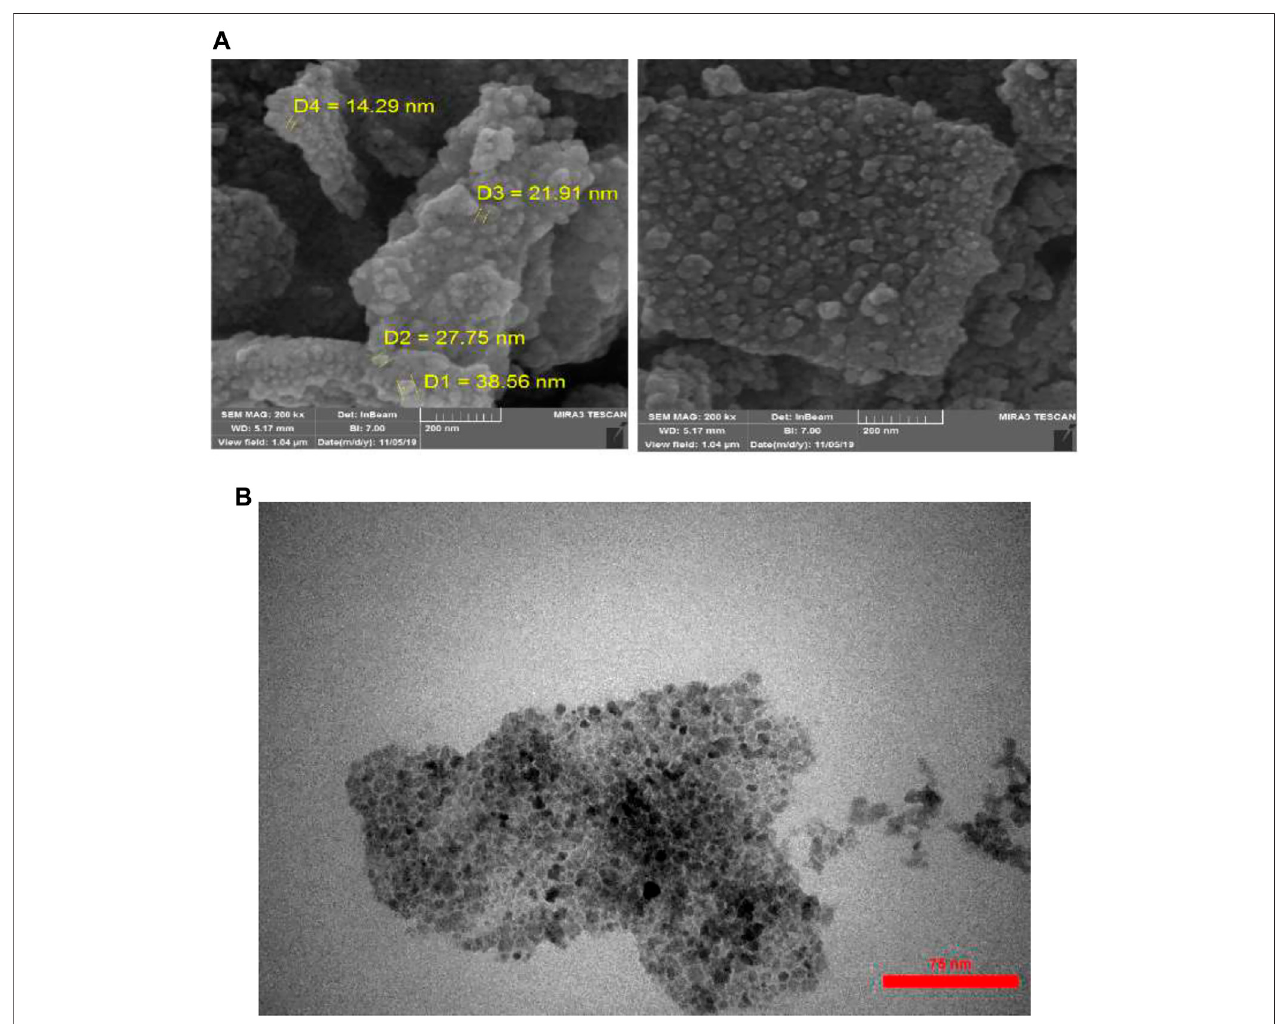
FIGURE 1 | (A) FE-SEM and (B) TEM images of synthesized Fe 3 O 4 @SiO 2 -pr@dapsone-Cu.